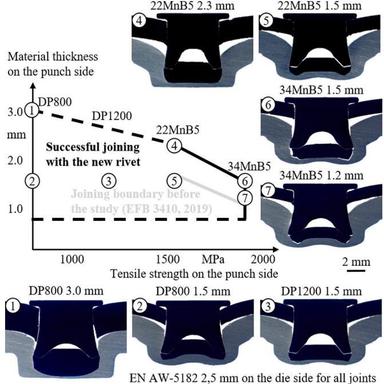
Process boundaries for joining with the new rivet.